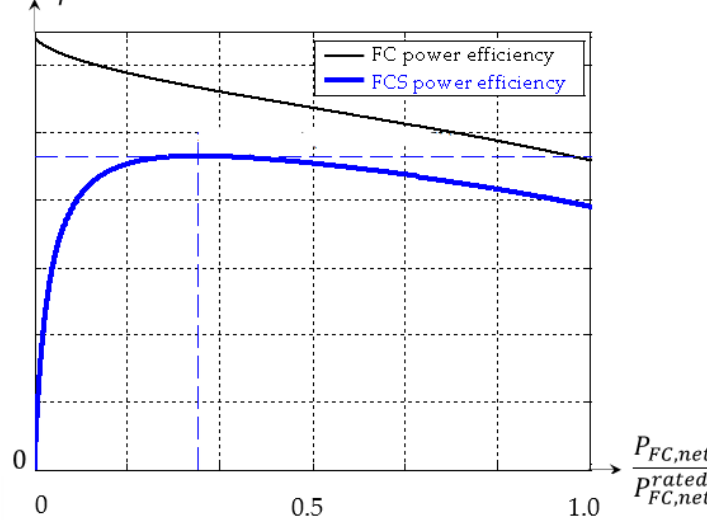
Figure 26. FCS e ffi ciency curve (boldly blue